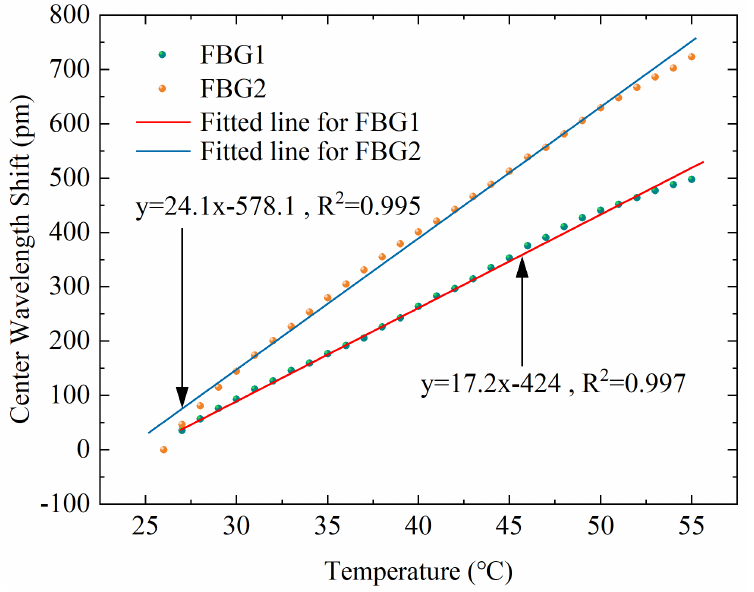
Figure 10. Corresponding response curves of the center wavelength shift with different temperatures for the two FBGs.